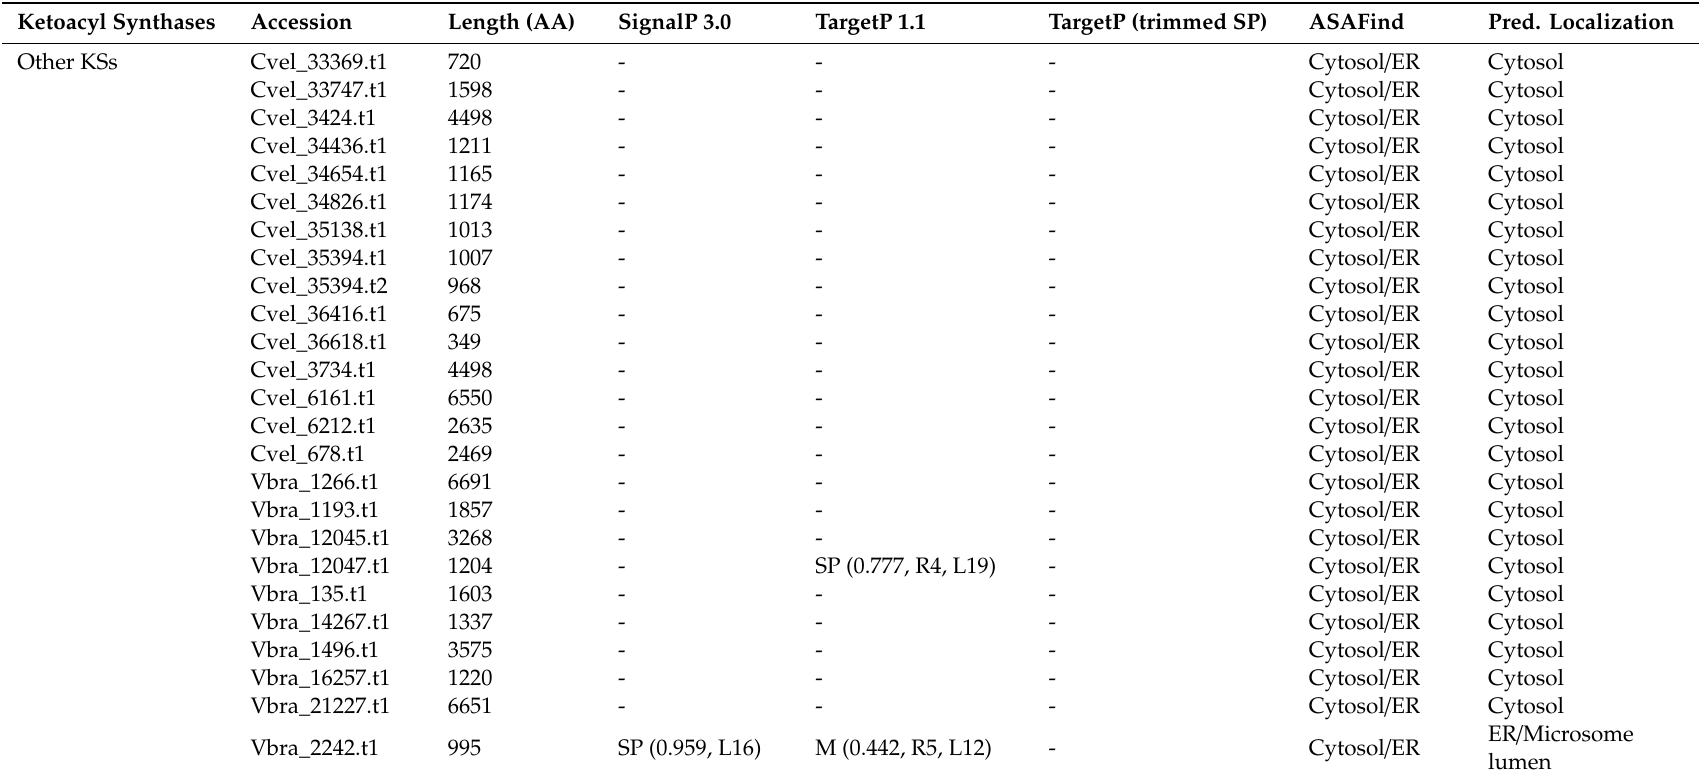
Table 2. Ketoacyl synthases, elongases, and desaturases in chromerids and their predicted subcellular location. Ketoacyl